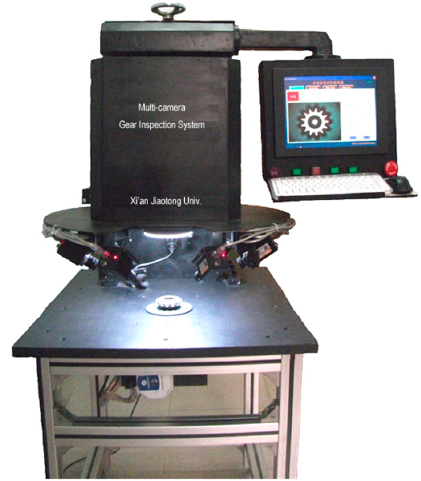
Figure 6. Prototype of multi-camera bevel gear inspection system.